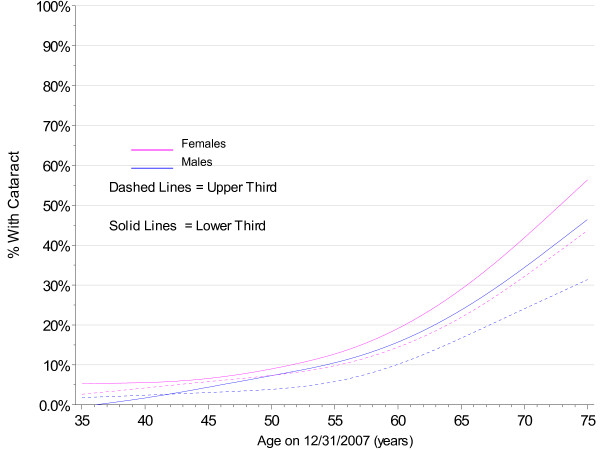
Smoothed 2007 Prevalence of Cataract by Gender and BMI (lower vs. upper third) Cohort with No Diabetes.